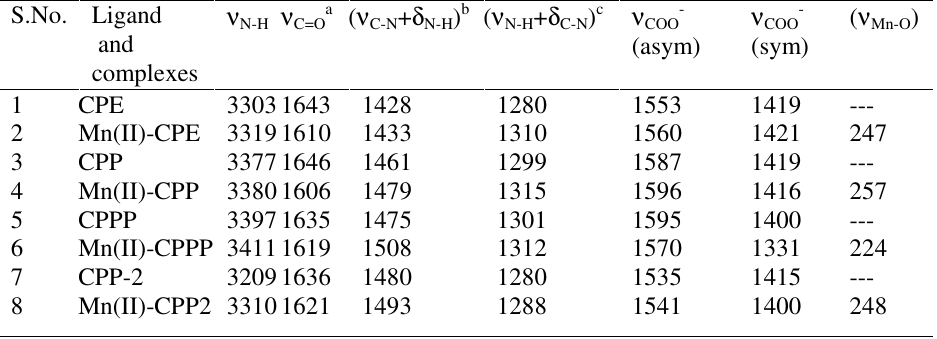
Table 1. Physico-Chemical Data of Mn(II) complexes (C.M. = conventional method; M.M. = Microwave method)